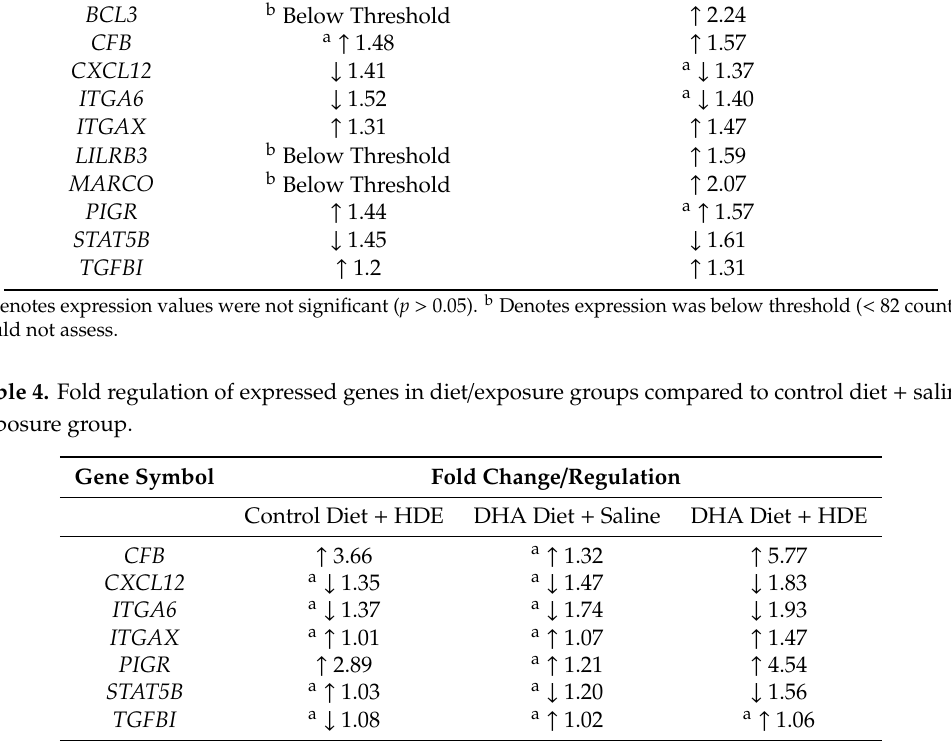
Table 3. Fold regulation of expressed genes in DHA-related samples. Gene Symbol